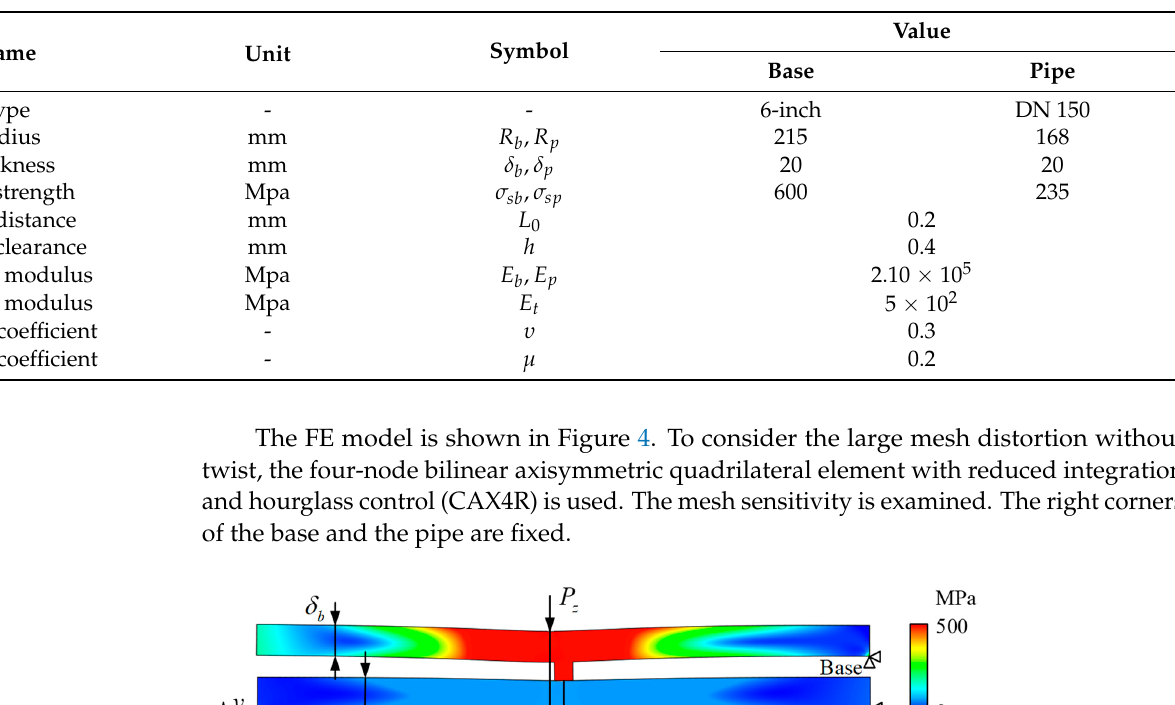
Table 1. Geometrical parameters and material properties.